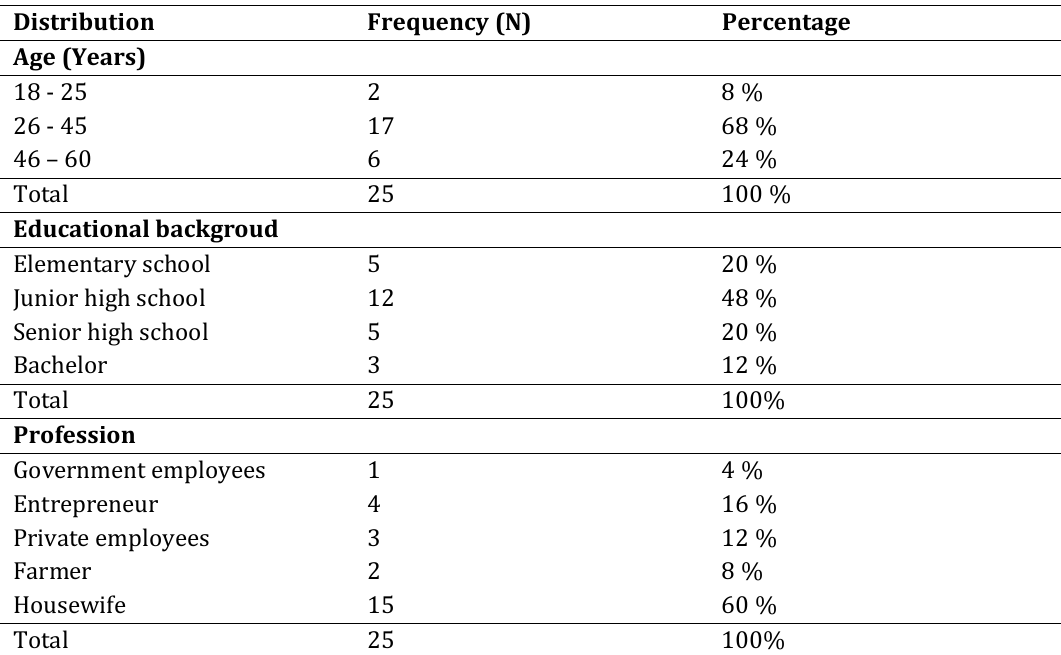
The distribution of the study participant Distribution Frequency